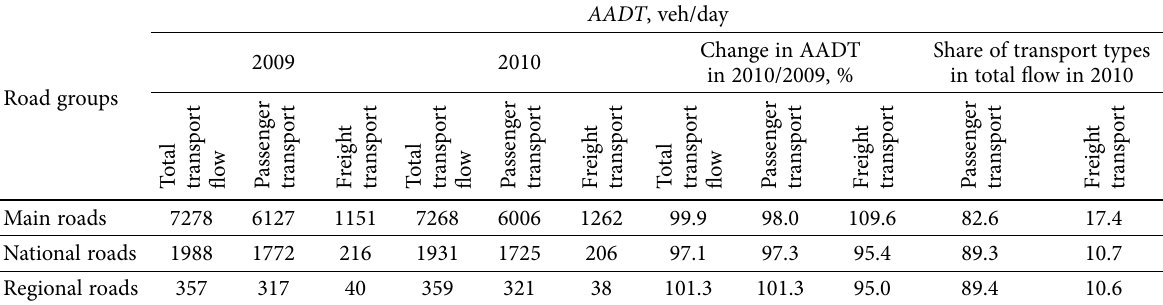
Table 2. AADT for each vehicle class depending on road groups in 2009–2010